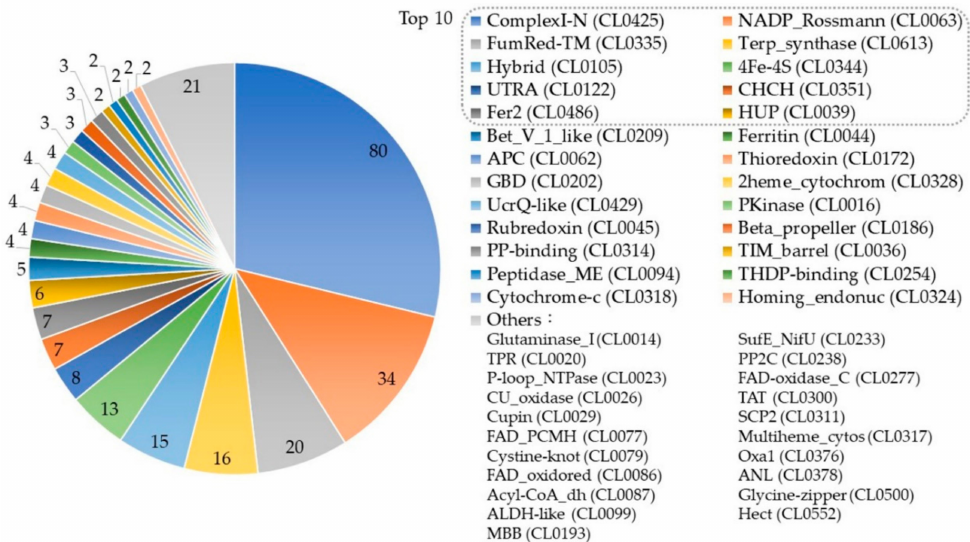
Figure 5. The superfamily distribution of the selected Ubiquinone-binding proteins (UBPs). The digital labels on the chart represent the number of UBPs that the superfamily contains. The names of the categories listed in the legend are the clan name in the Pfam database. All superfamilies in the “Others” category contain one